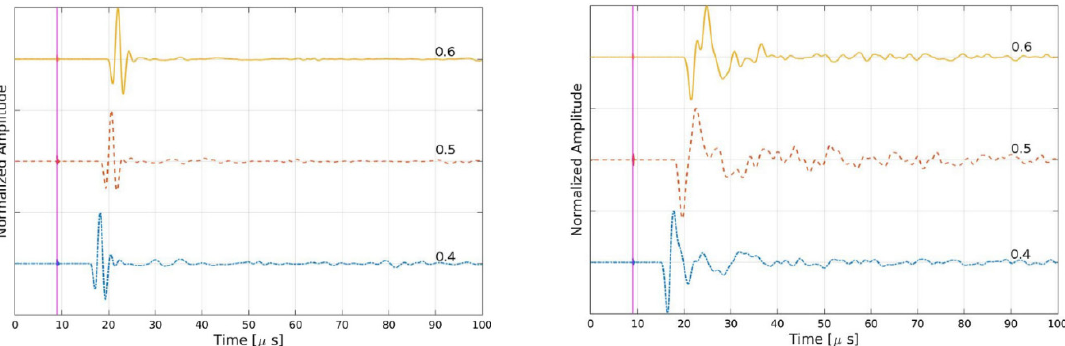
Figure 8. Signals from non-carbonated and carbonated cement paste [81]. The number in the graphs presents the ratio of water and cement.